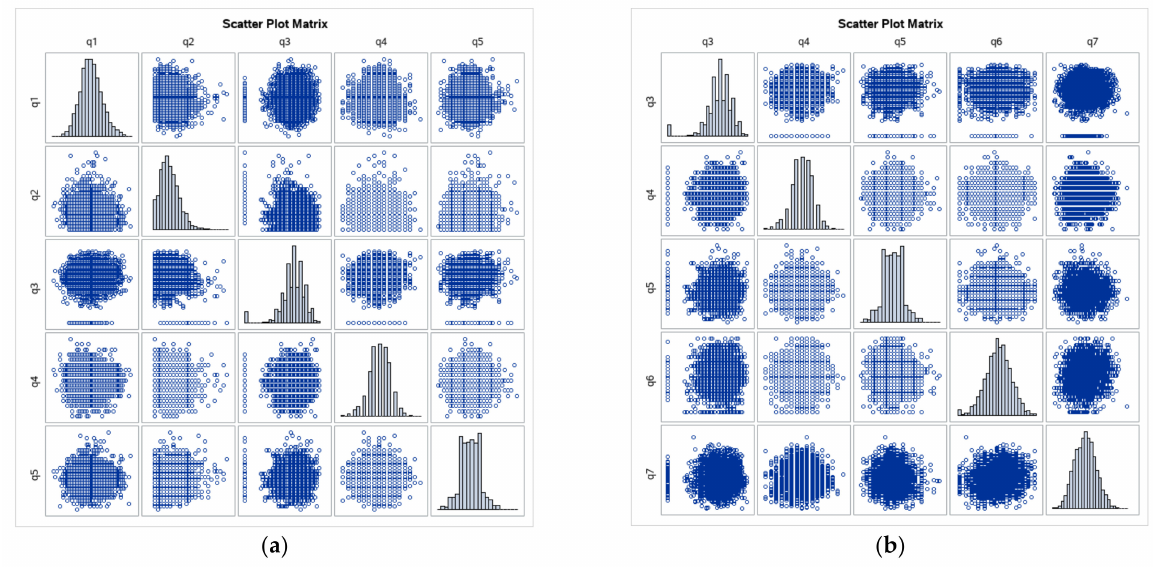
Figure 2. Scatter plot and distribution of variables ( a ) q1 – q5, ( b ) q3 – q7 of the pre-trial data set.